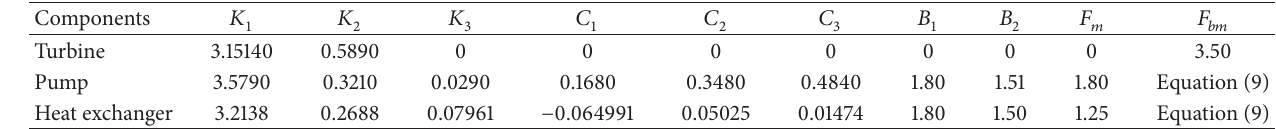
Table 4: Coefficients required for the cost evaluation for each component [26].